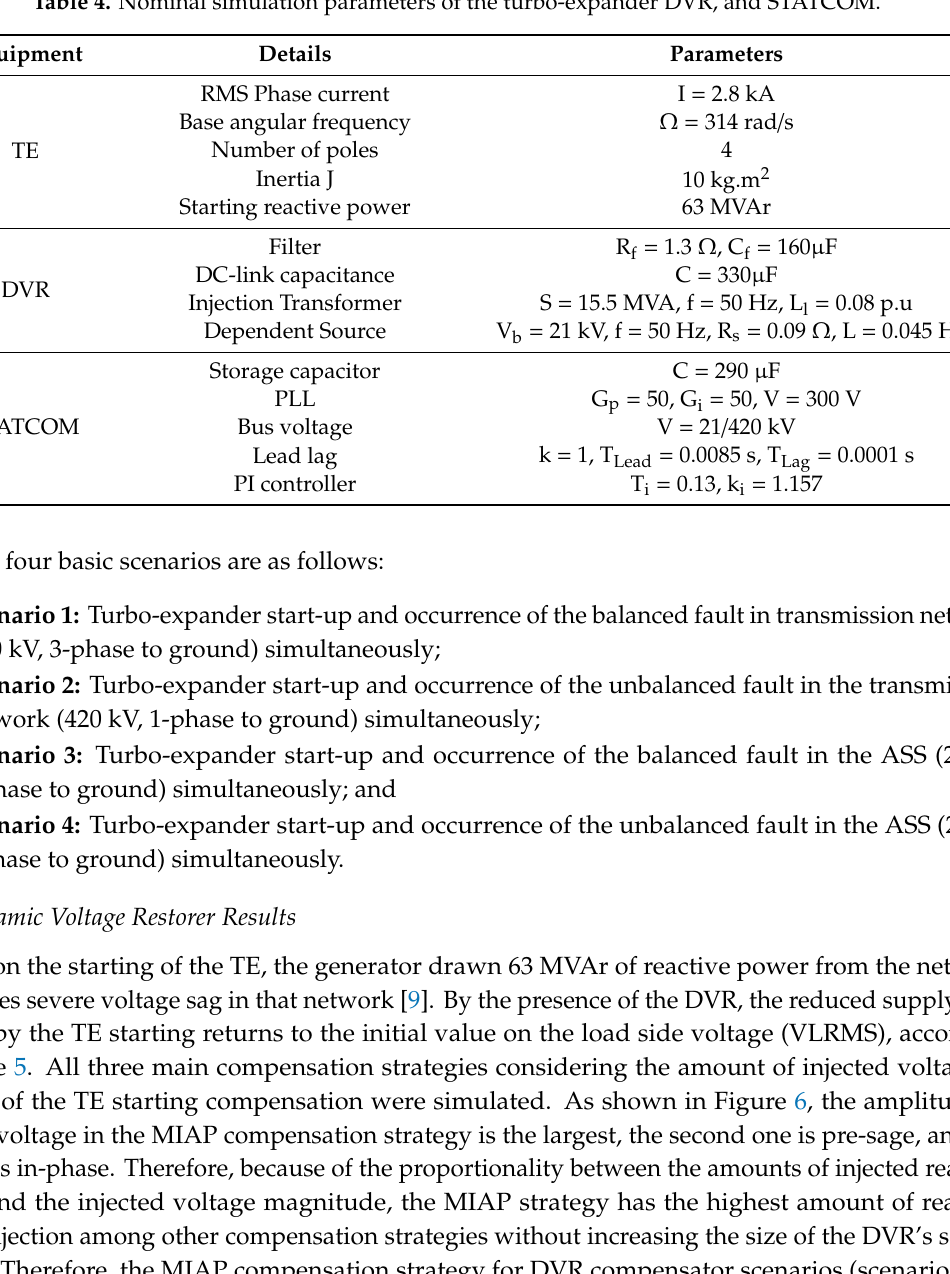
Table 4. Nominal simulation parameters of the turbo-expander DVR, and